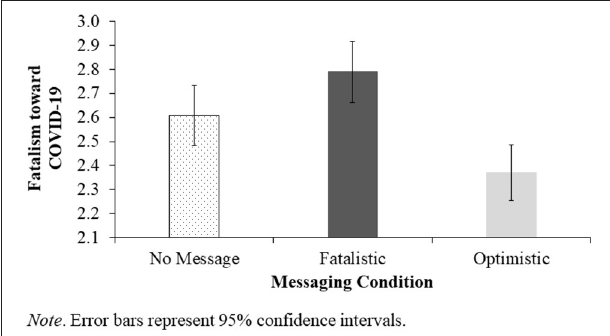
FIGURE 1 | Effect of Messaging Condition on Fatalism toward COVID-19.